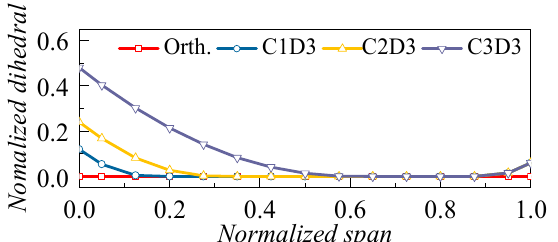
Figure 14. Radial distribution of blade dihedral for the cases with different dihedral heights.